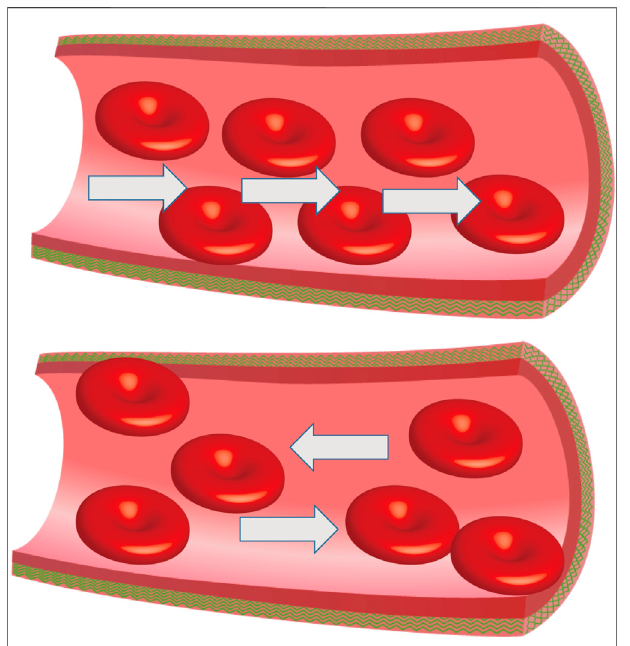
FIGURE 1 | Abnormal venous valve function. Damaged venous valves result in local venous return, the white arrow represents the direction of blood fl ow.